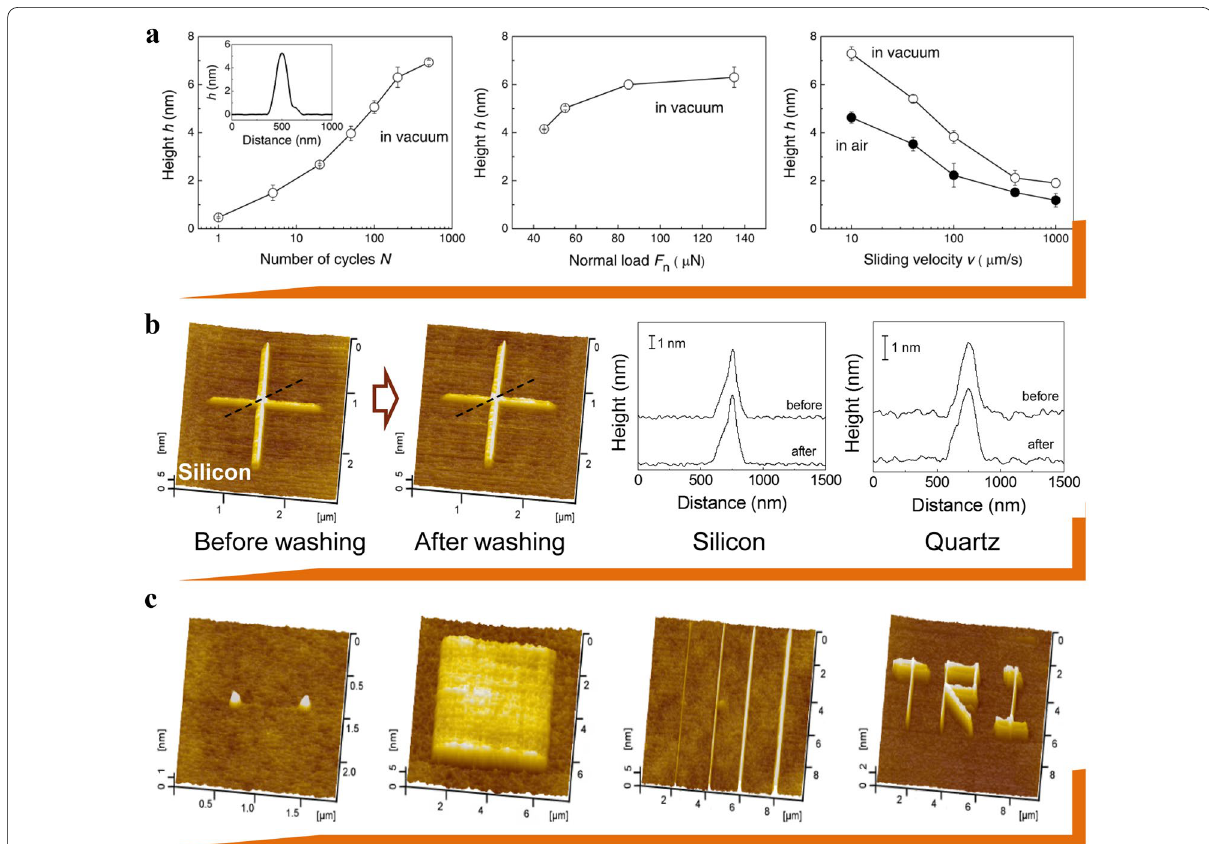
Figure 5 ( a ) Hillock height h as a function of number of scratching cycles N , applied normal load F n , and sliding velocity v [26]. ( b ) AFM images and corresponding cross-sectional profiles of friction-induced hillocks on silicon and quartz surfaces before and after washing [47]. ( c ) AFM images of various protrusive nanostructures (i.e., nanodots, surface isolated mesa, nanoline array, and pattern of “TRI”) produced by reciprocating scratching on silicon surface